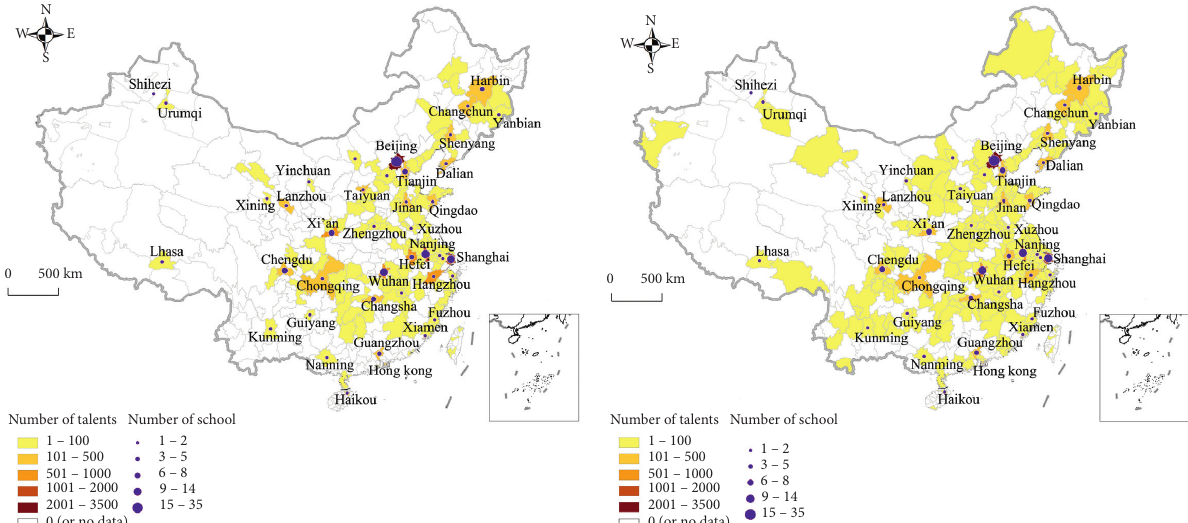
Figure 4: The spatial distribution map of China’s high-level talents 985 and 211 universities.